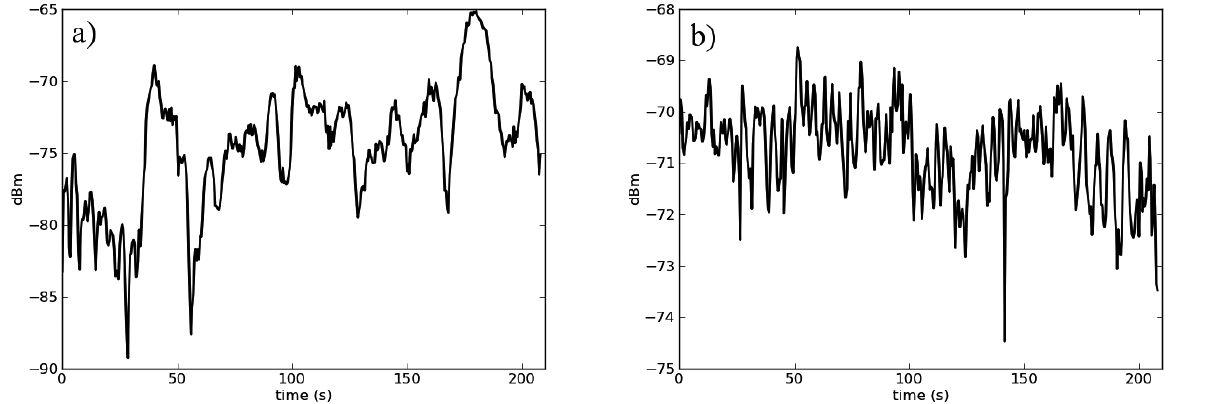
Figure 8. Power observations of two almost consecutive data segments of 210 s showing different fading levels and different periodicities recorded on January 14, 2008, at (a) 06:55 UT and (b) 07:55 UT respectively.